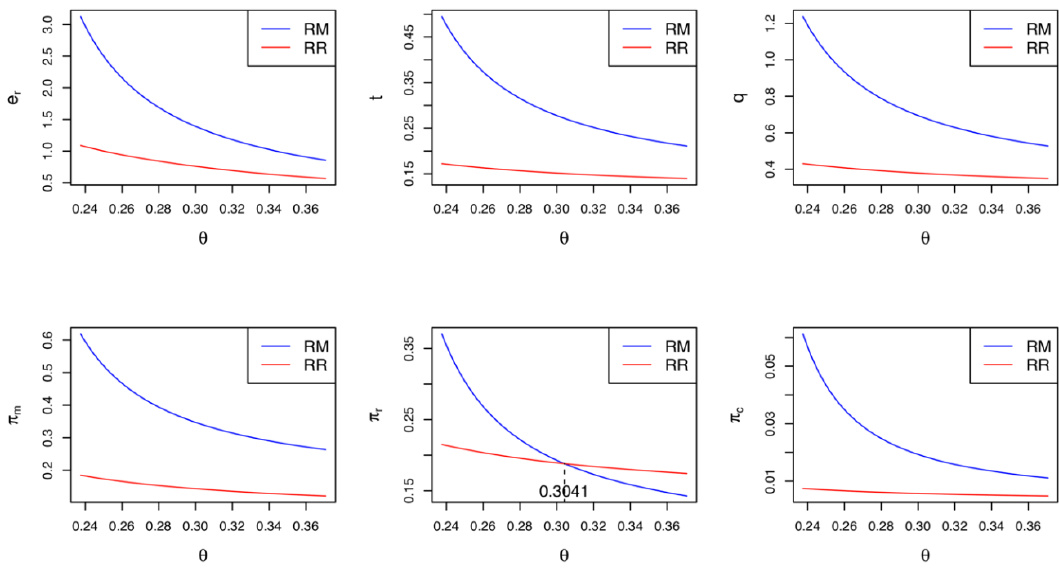
Figure 3. Comparisons between Model RR and Model RM.